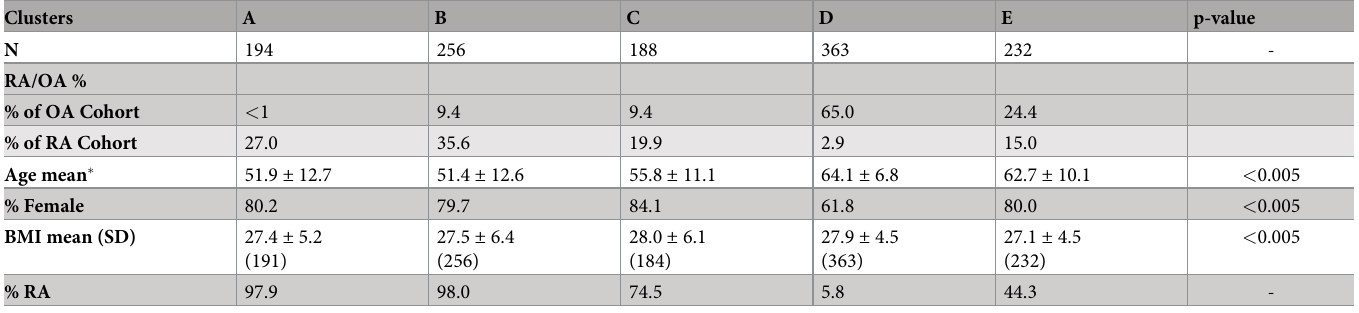
Table 2. Descriptive statistics for each cluster identified through hierarchical clustering, with p-values calculated using ANOVA test to identify differences between the clusters.